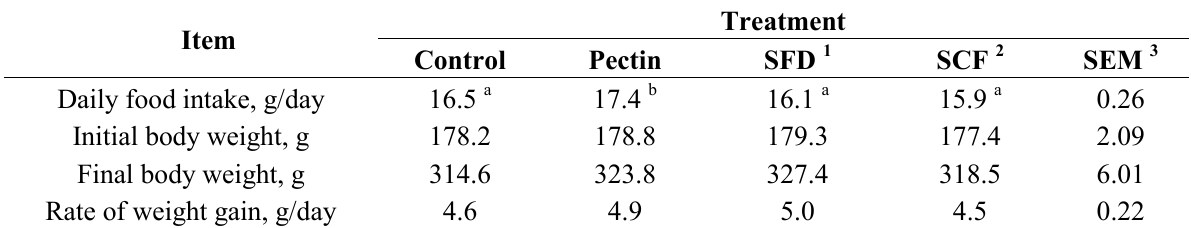
Table 2. Daily food intake, rate of weight gain, and final body weights of rats fed select dietary